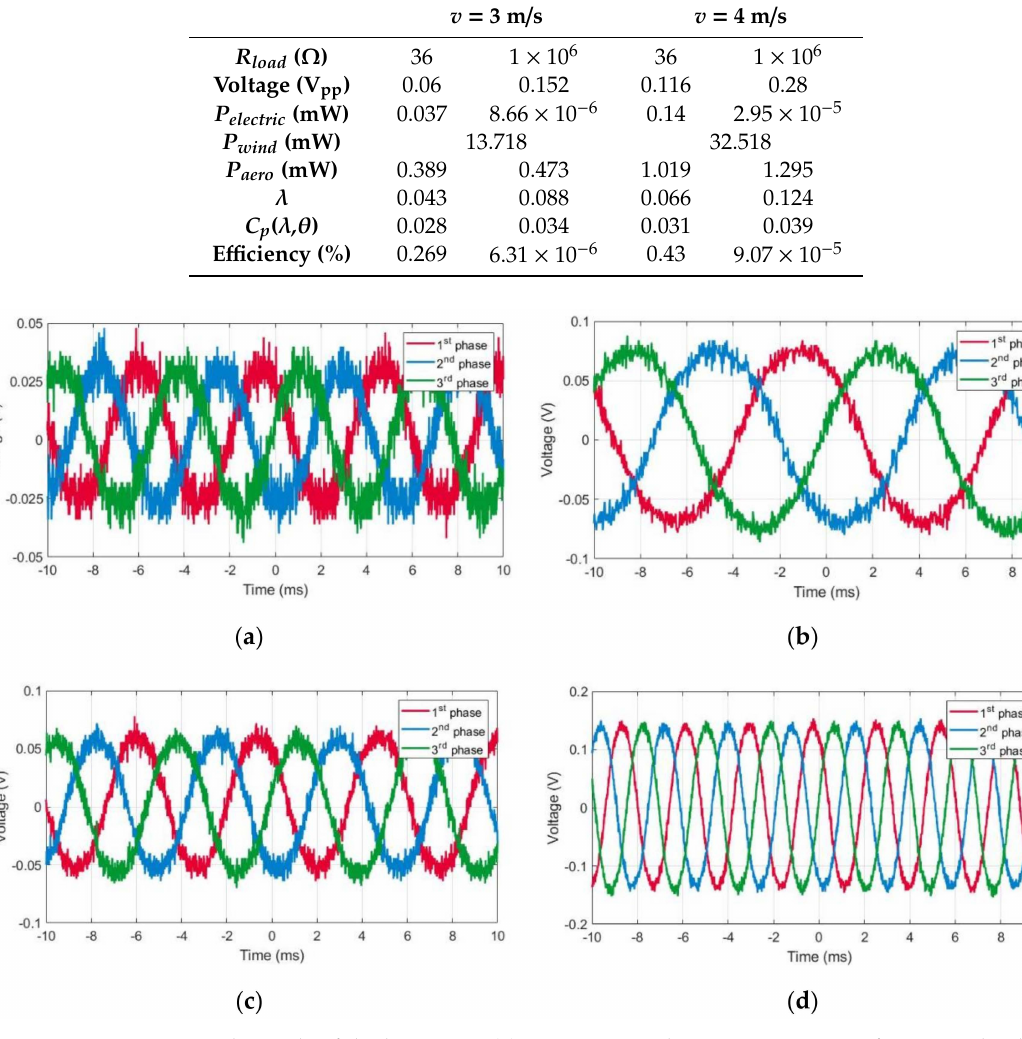
Figure 12. Measured signals of the harvester. ( a ) A 3 m / s air velocity in open space for a 36 Ω load. ( b ) A 3 m / s air velocity in open space for a 10 6 Ω load. ( c ) A 4 m / s air velocity in open space for a 36 Ω load. ( d ) A 4 m / s air velocity in open space for a 10 6 Ω